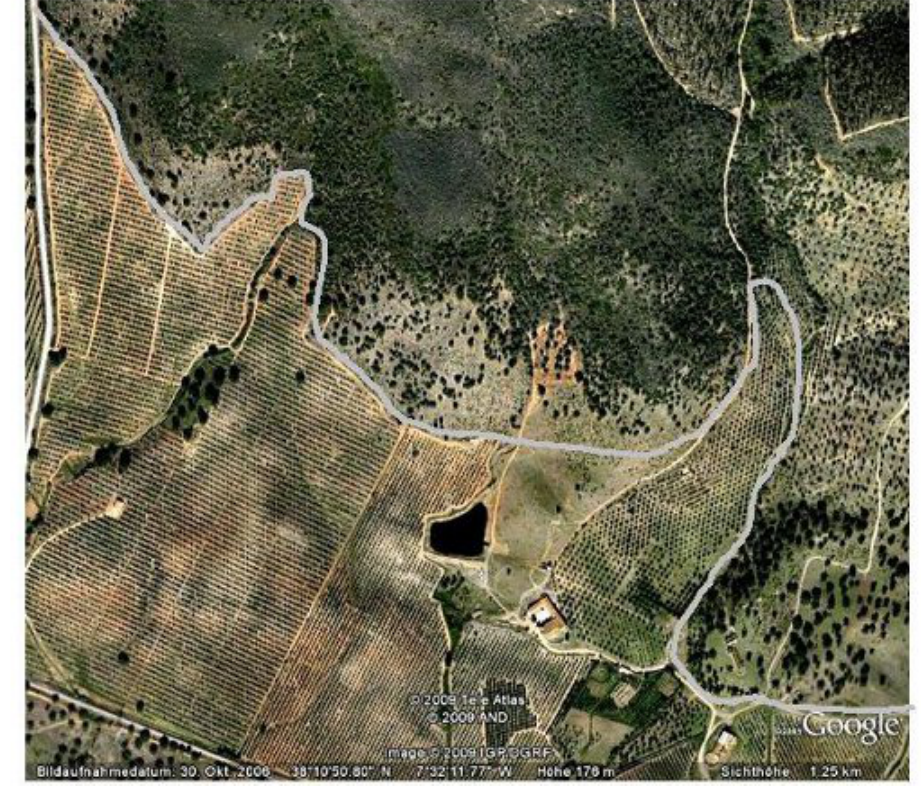
Fig. 5. Conversion of montado (over the gray line) to olive orchards (under the gray